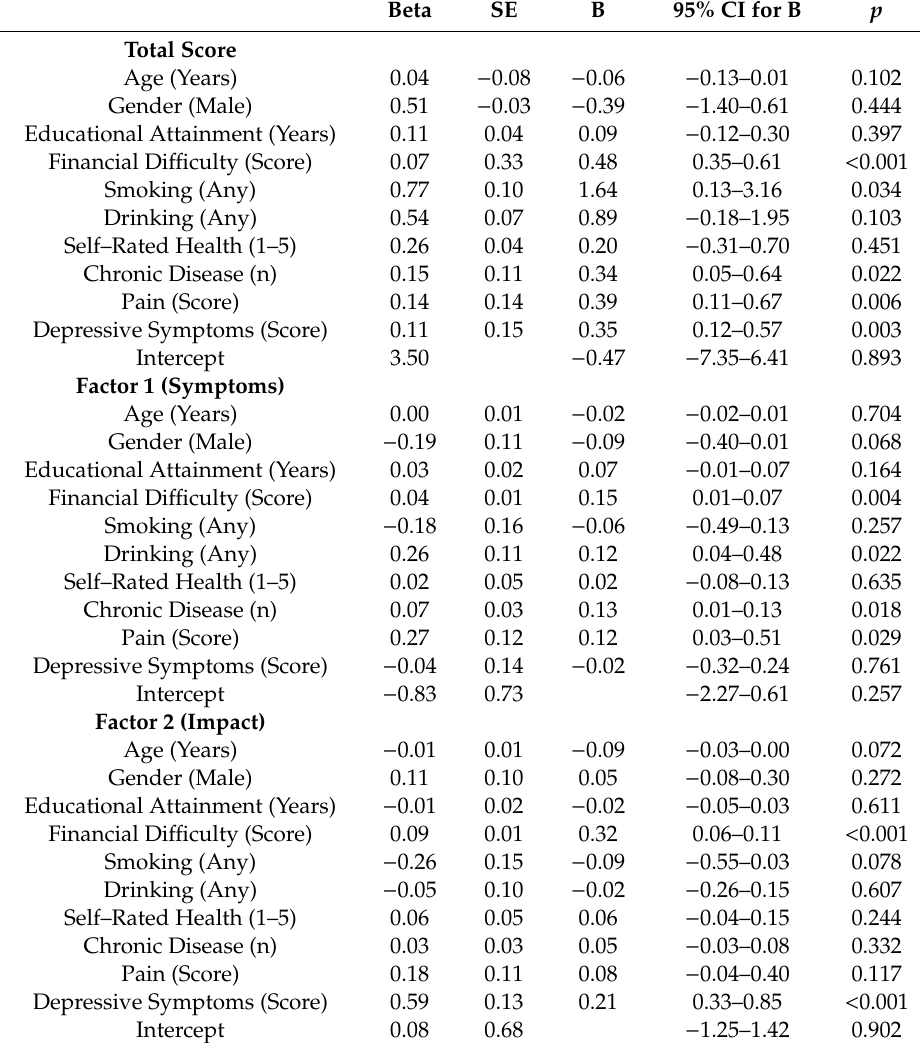
Table 4. Linear regressions on predictors of insomnia